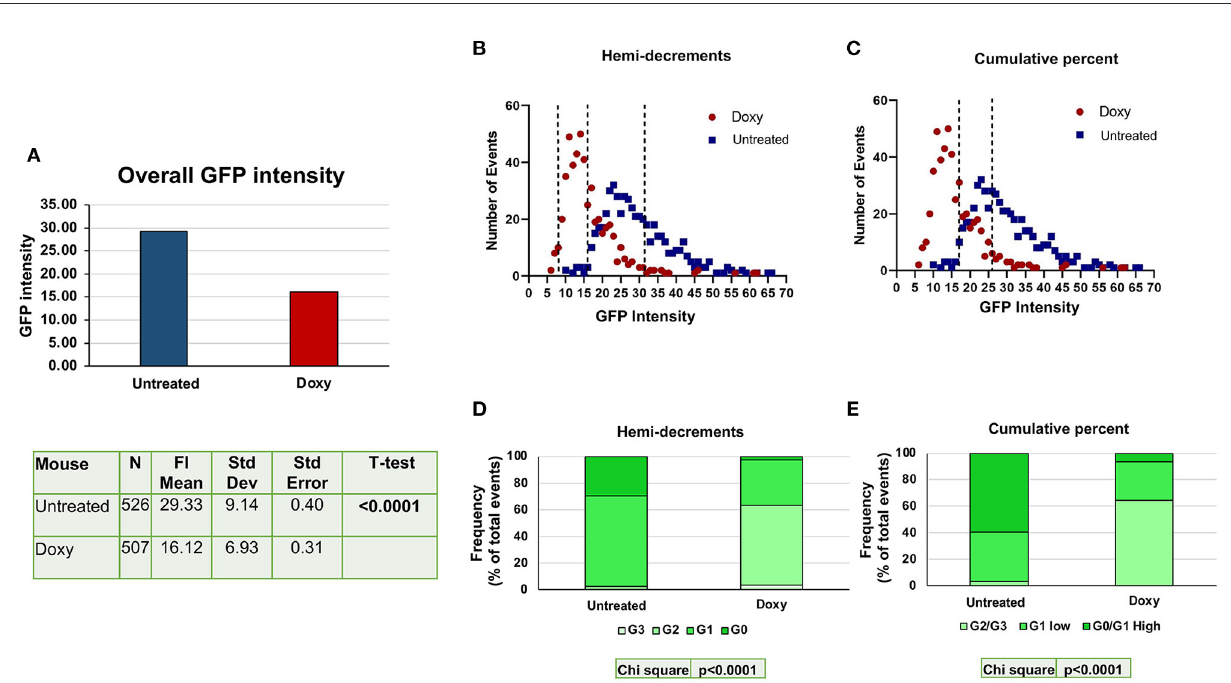
FIGURE3 Doxy reduces the levels of GFP expressed by the single cells detected by confocal microscopy in the femur sections from untreated or Doxy-treated mice. (A) Comparison between the overall GFP levels expressed by single cells from the BM sections of the untreated (blue) and Doxy-treated (red) mice (two mice per group), as indicated. All the GFPpos cells present in one section were considered. The data are reported with statistical analyses in a table format below the graph. (B) Distribution of the GFP levels expressed by individual cells (each dot a different cell) from the femur of untreated (blue dots) and Doxy-treated (red dots) mice, as indicated. In this case, the GFP levels are divided into four classes by hemi-decrement analyses of the maximal levels of GFP intensity determined. (C) The same distribution of the GFP levels shown in B but divided into 3 classes according to the cumulative percentage of the values distribution. The total number of events presented in (B, C) is 1,033 (526 for untreated and 507 for the Doxy-treated group). (D, E) Frequency of the cells in the various GFP classes over the total frequency of SLAM cells observed in the BM of either untreated or treated-mice. Data are presented as mean of those observed with two mice per group. Both in (D, E) , differences in cell distribution among the classes in the two groups are statistically significant by Chi-Square